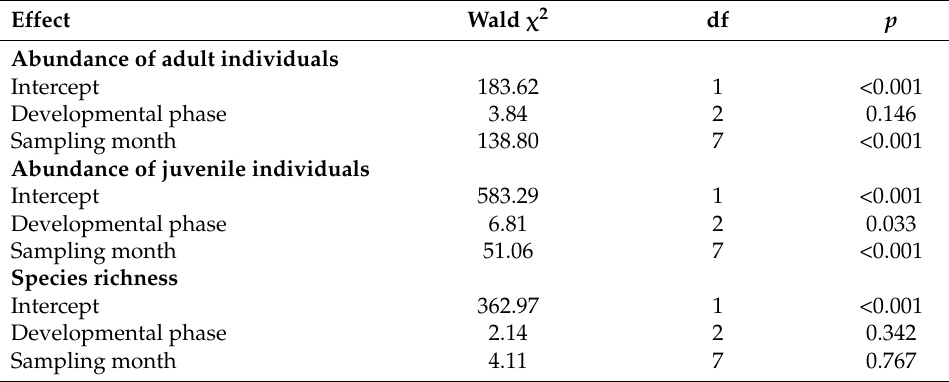
Table 6. Results of generalised linear models assessing the effect of the developmental phase of the tree stand and sampling month on the abundance and the species richness of spider assemblages of tree